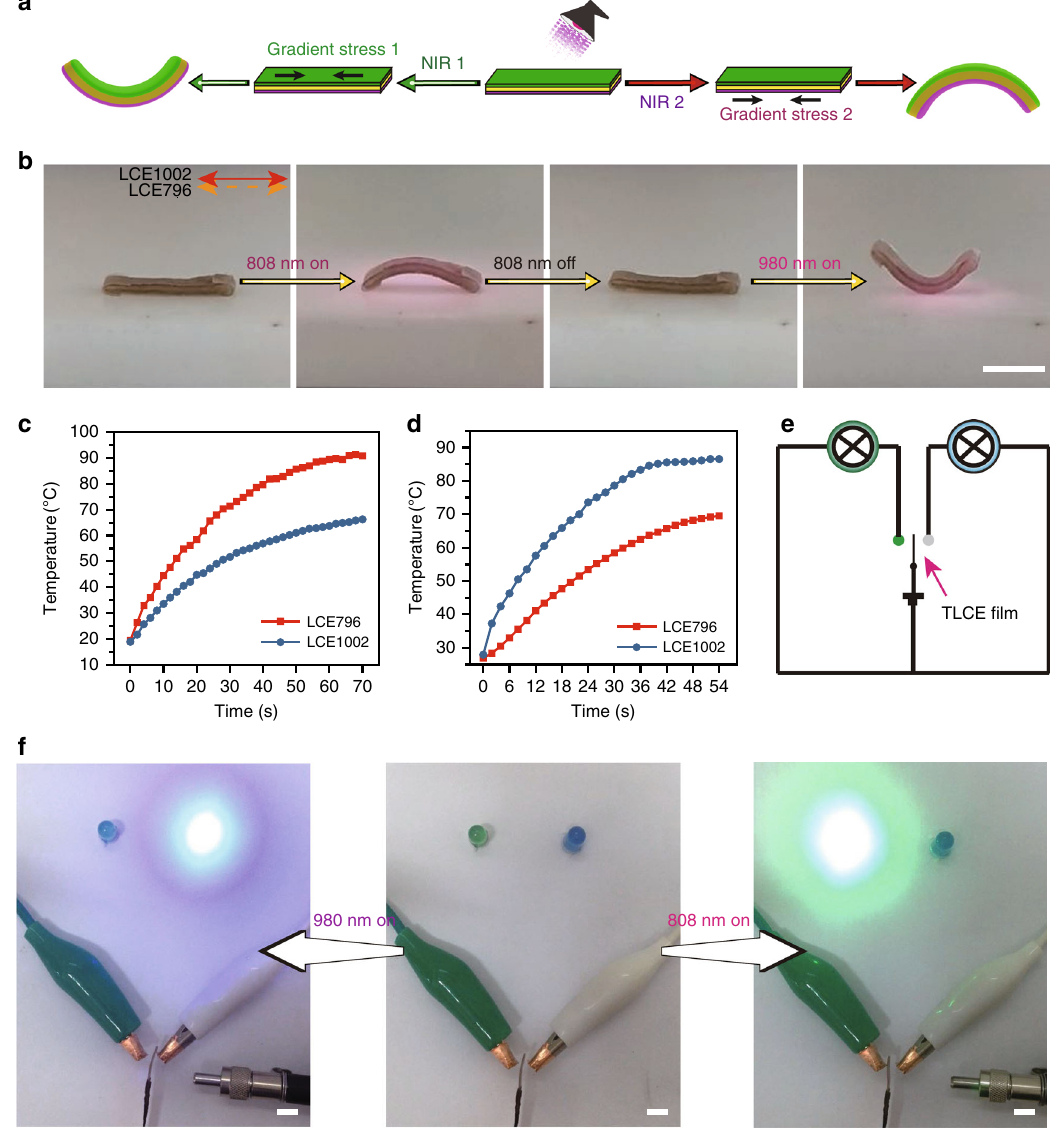
Fig. 2 NIR dual-wavelength modulated two-way switch. a Schematic illustration and b the real image records of NIR dual-wavelength-selective shape deformations of a TLCE fi lm (scale bar = 0.5 cm). The diagrams of the surface temperatures of the bottom LCE796 and upper LCE1002 layers of the TLCE sample plotted against the illumination time of c 808 nm and d 980 nm NIR light. e Circuit diagram of the designed two-way switch device. f Photographs of a TLCE fi lm coated with conductive material acting as a two-way switch under the control of 808 nm and 980 nm NIR light. Source data are provided as a Source Data fi